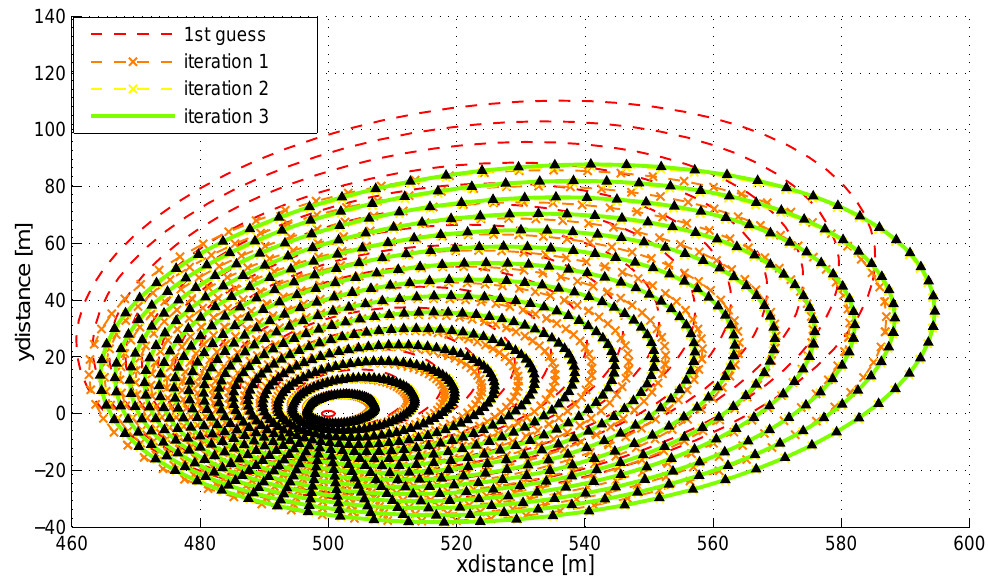
Figure 3. Guess, observation and iterations of fire fronts in an x – y plane (plan view of a wildfire). The black triangles are the 15 observed perimeters. The red dashed lines are the fire fronts generated with the first guess and the dashed lines are the following iterations. The last iteration is the green solid